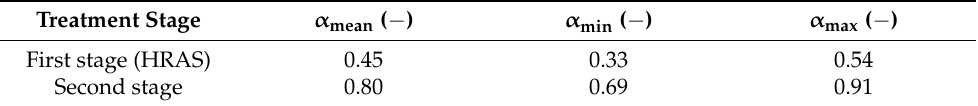
Table 3. The α -factors for design load cases of two-stage activated sludge